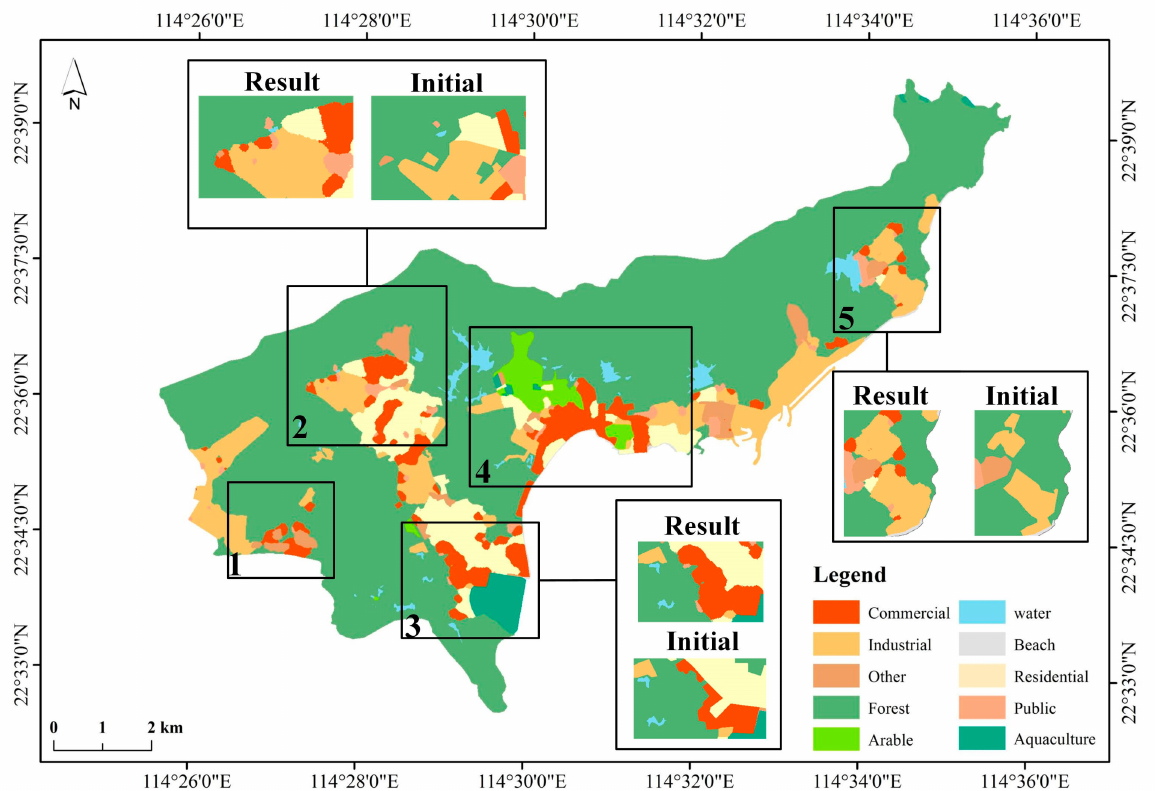
Figure 9. The final optimal pattern of land use showing different land uses (colored as per the Legend) with example zoomed in comparisons. Changes in land use in the numbered regions from 1 to 5 are referred to in the main